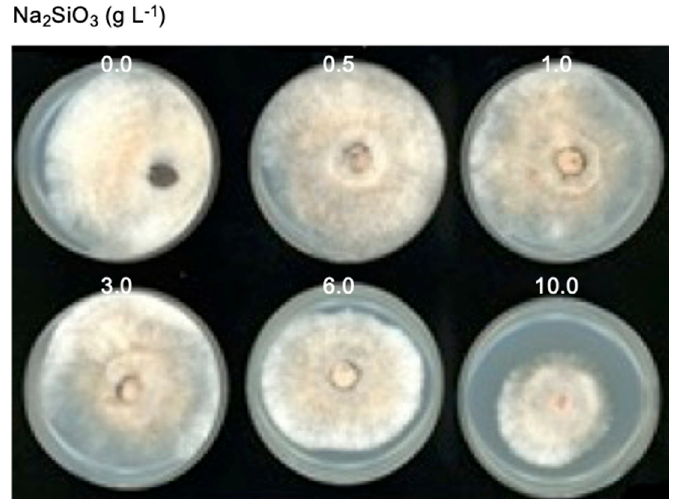
Figure 6. Antifungal effect of different concentrations of Na 2 SiO 3 (g L − 2 ) on the growth of Calonectria ilicicola . Table 2. In vitro inhibition of the growth of Calonectria ilicicola at different concentrations of Na 2 SiO 3.